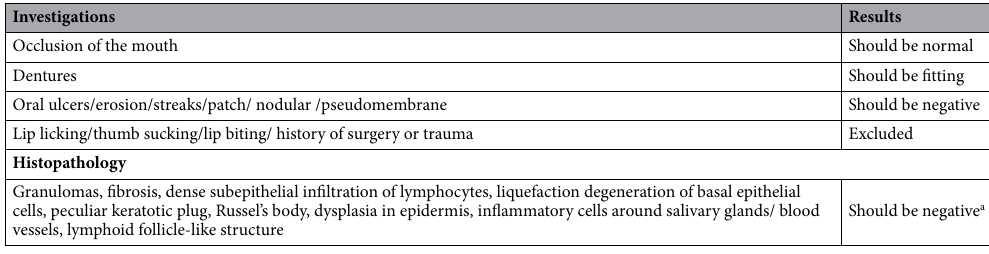
Table 1. Diagnostic investigations and criteria of chronic cheilitis. a Biopsy was not obtained as part of the diagnostic work-up, but was necessary when there are clinical features compatible with potential diagnosis of other mucosa diseases, such as granulomatous cheilitis, actinic cheilitis, Melkersson–Rosenthal syndrome, cheilitis glandularis, oral lichen planus, discoid lupus erythematosus,